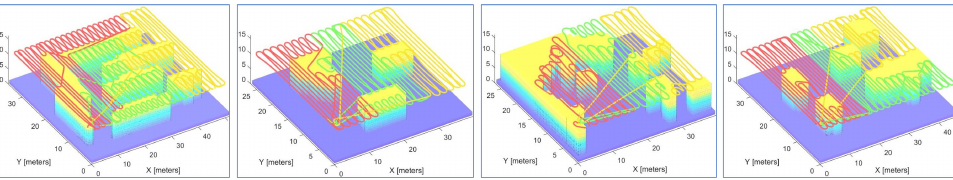
Figure 19. UAV simulated paths of CDM with three